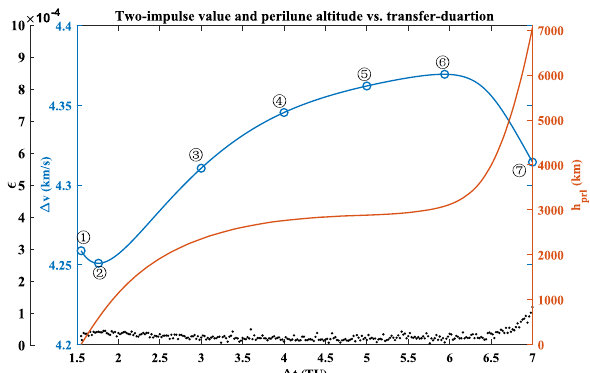
Figure 8. Two-impulse value and perilune altitude vs. transfer-duration.